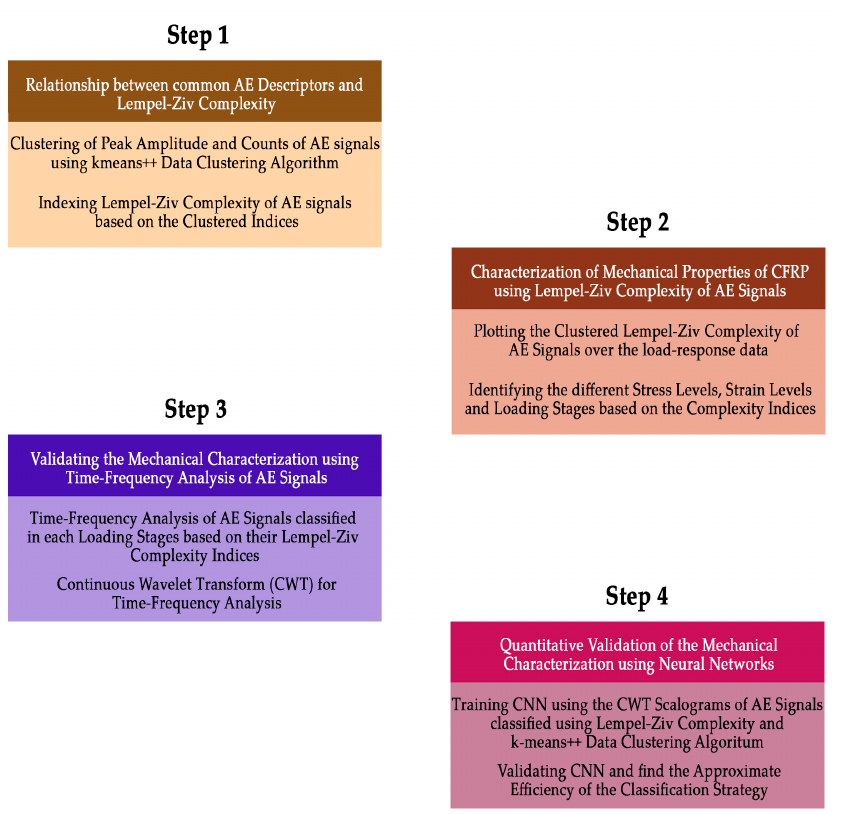
Figure 1. Four-Step Classification Methodology for Mechanical Characterization of CFRP Composites Figure 1. Four ‐ Step Classification Methodology for Mechanical Characterization of CFRP Compo ‐ using Acoustic Emission Signal sites using Acoustic Emission Signal Data.